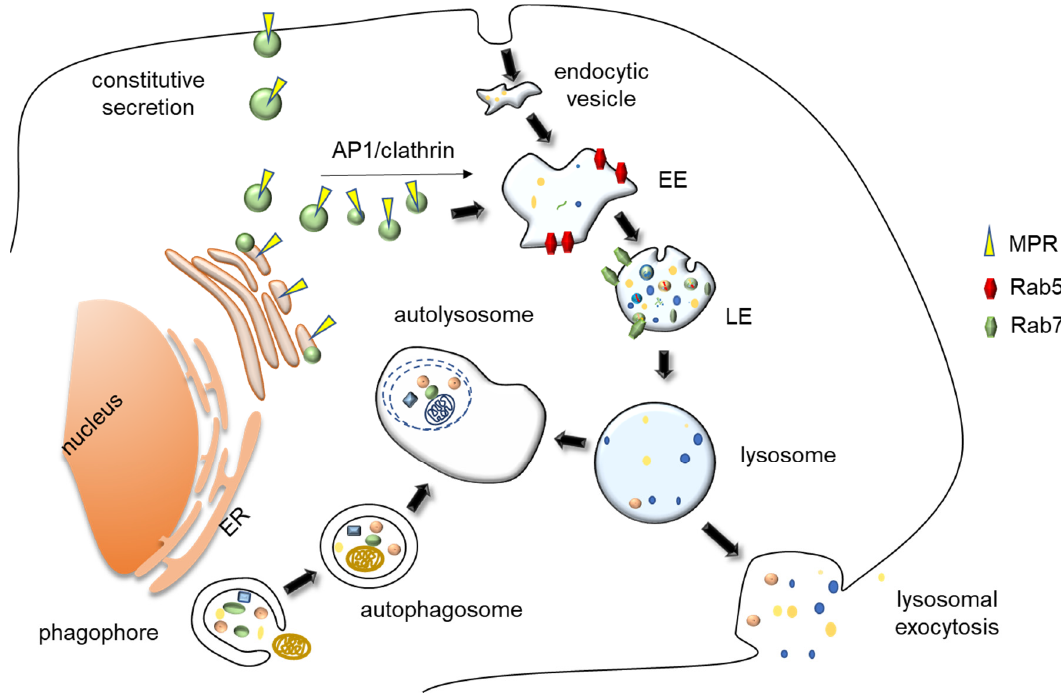
Figure 1. Representation of lysosomal biogenesis, major trafficking route and exocytosis. Materials to be degraded into lysosome can be either of extracellular or intracellular origin. Cells receive their extracellular cargoes for degradation by different forms of endocytosis and their intracellular cargoes by different forms of autophagy, namely by macroautophagy, which includes the engulfment of large cytoplasmic entities and damaged organelles within a double membrane structure, the autophagosome. This entity then fuses with lysosomes, forming an autolysosome. Lysosome biogenesis requires both the biosynthetic and endocytic pathways. Lysosomes receive their specific soluble hydrolases and membrane proteins cargos from the “conventional” secretory pathway. Briefly, in the trans-Golgi, M6P receptors bind to proteins carrying mannose 6-phosphate residues, interact with AP1 / clathrin complexes, and bud from the apparatus as vesicles. Lysosomal membrane proteins are delivered to lysosomes in a M6P receptor-independent manner, as their transport from the trans Golgi network to the lysosome occurs both by a direct route or indirectly via vesicle fusion with plasma membrane, followed by endocytosis. These vesicles fuse with endosomes, delivering their lysosomal protein precursor content. EE, Early endosomes; LE / MVB, Late endosomes / MultiVesicular Bodies; MPR, Mannose Phosphate Receptors; ER, Endoplasmic